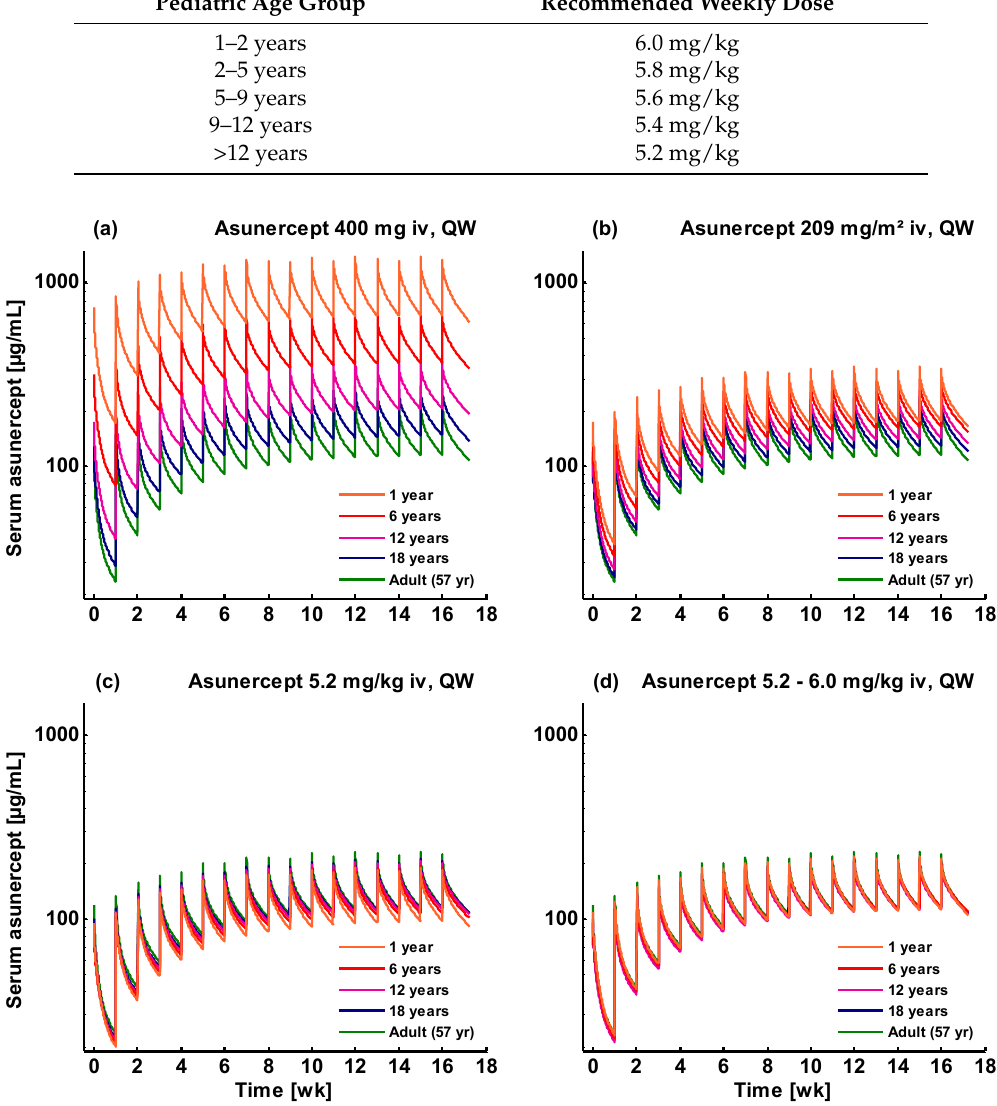
Figure 6. Simulated asunercept serum concentration-time profiles using different dosing approaches in pediatric patients. ( a ) Weekly infusion of a fixed dose of 400 mg; ( b ) weekly infusion of a body surface area normalized dose of 209 mg/m²; ( c ) weekly infusion of a body weight normalized dose of 5.2 mg/kg; ( d ) weekly infusion of the recommended doses (see Table 4). Orange: 1-year old patient; red: 6-year old patient; purple: 12-year old patient; blue: 18-year old patient; green: adult Phase II study reference patient. Simulations were conducted using a sialic acid:glycan ratio of 0.64 for asunercept.